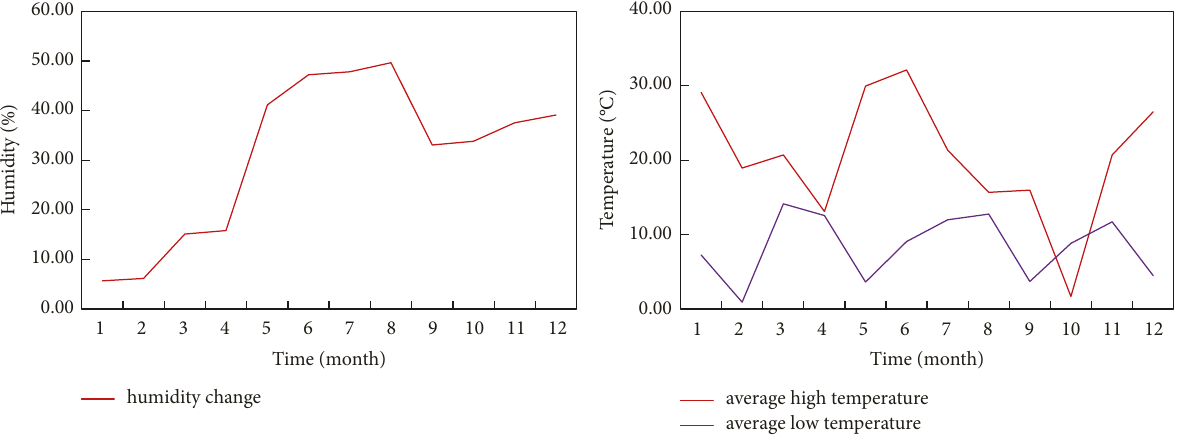
Figure 4: Humidity and temperature changes in village M.